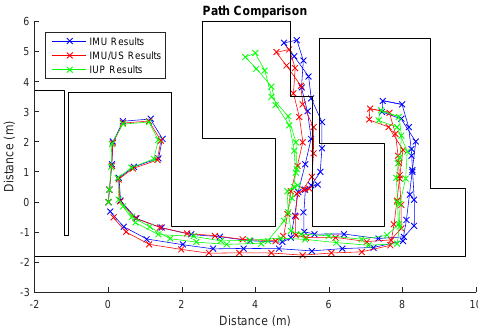
Figure A3. The tracked walking paths by the inertial measurement unit (IMU), IMU/ultrasound (US) and inertial/ultrasound/particle filter (IUP) systems for trial 2 of Type 2 walking.